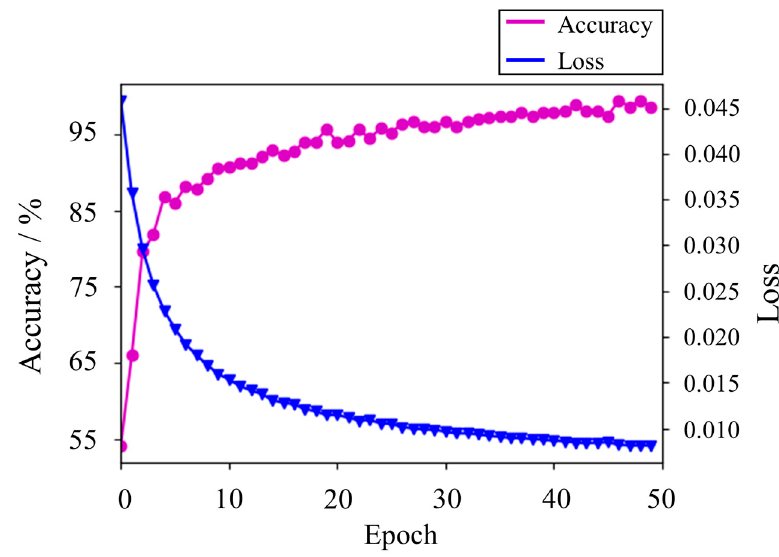
Figure 10. Training accuracy and loss curves.